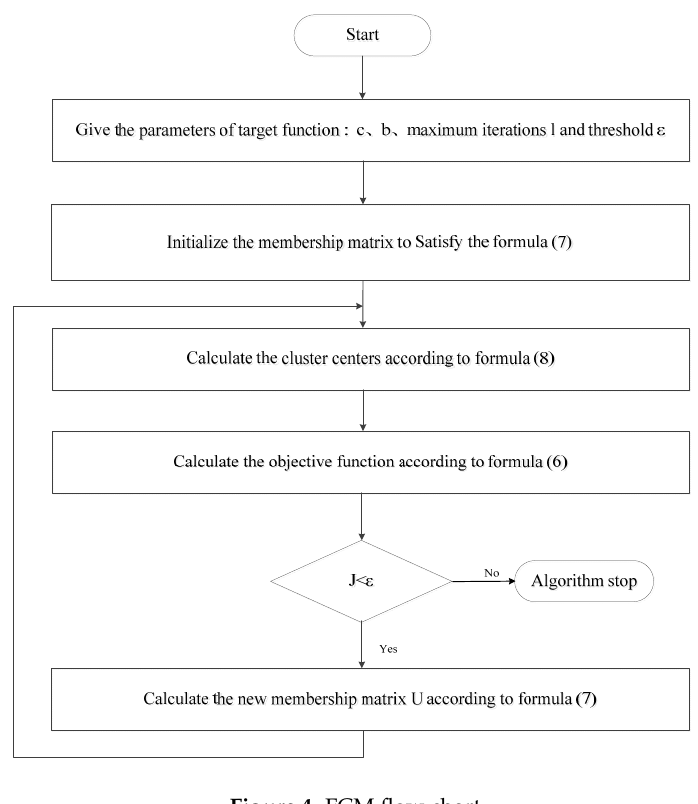
Figure 4. FCM flow chart.